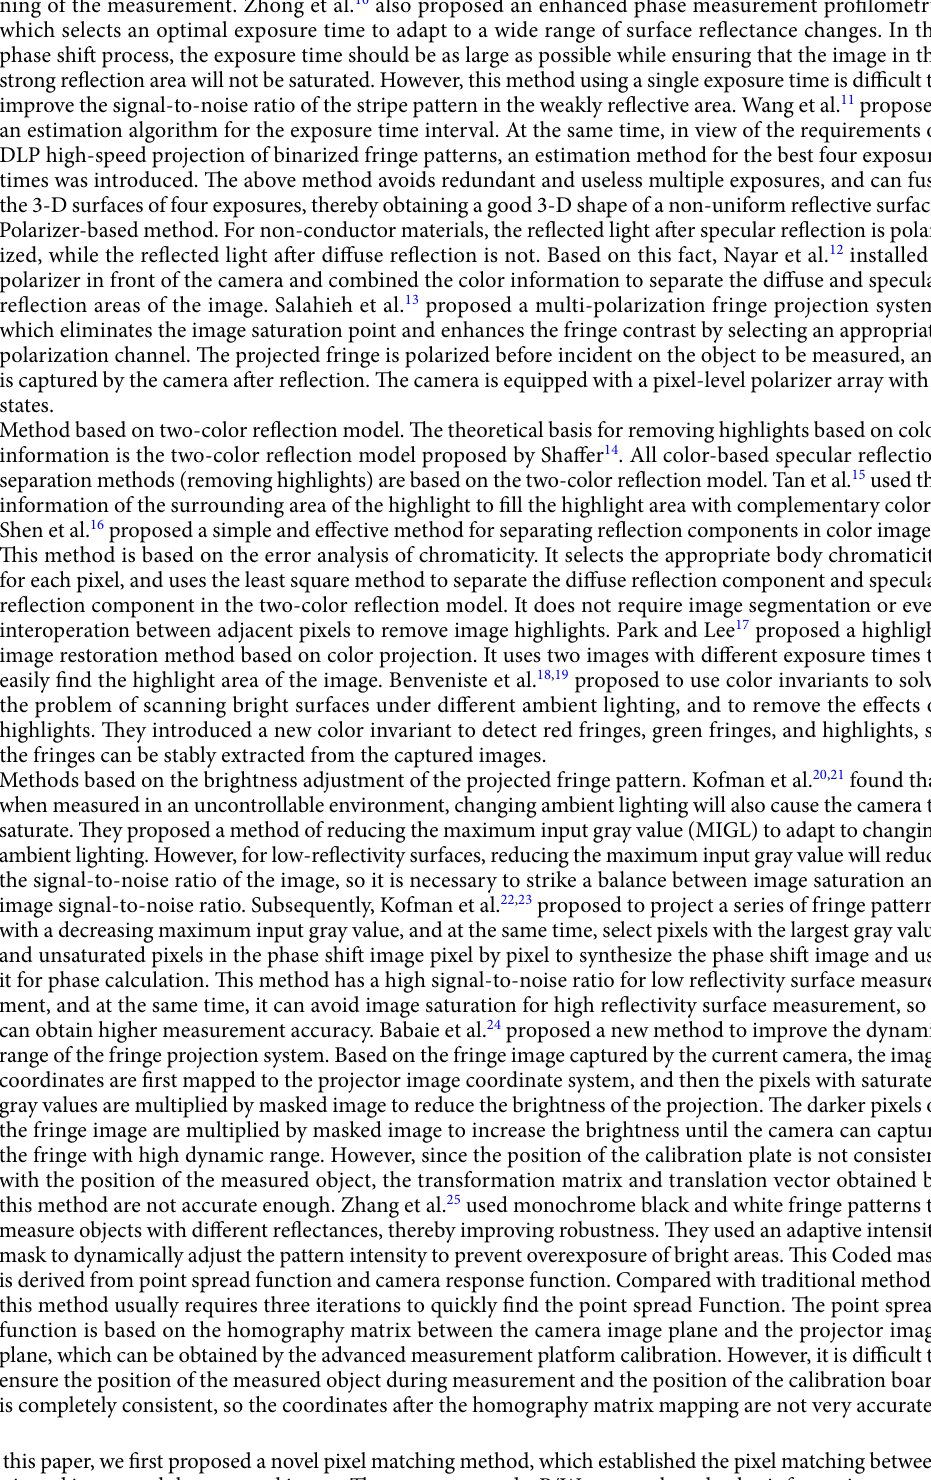
reflection component in the two-color reflection model. It does not require image segmentation or even interoperation between adjacent pixels to remove image highlights. Park and Lee 17 proposed a highlight image restoration method based on color projection. It uses two images with different exposure times to easily find the highlight area of the image. Benveniste et al. 18,19 proposed to use color invariants to solve the problem of scanning bright surfaces under different ambient lighting, and to remove the effects of highlights. They introduced a new color invariant to detect red fringes, green fringes, and highlights, so the fringes can be stably extracted from the captured images. (d) Methods based on the brightness adjustment of the projected fringe pattern. Kofman et al. 20,21 found